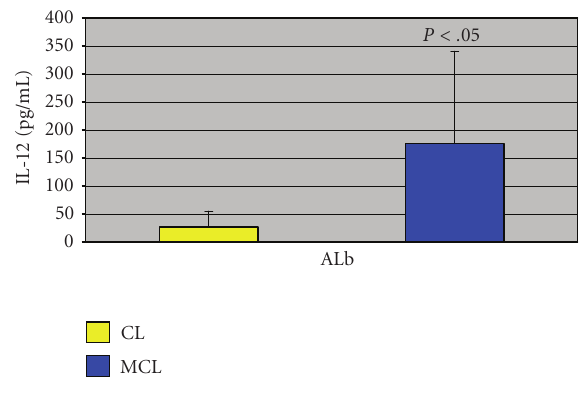
Figure 3: IL-12 production in cell-free supernatants of CL and MCL patients’ PBMCs measured by ELISA upon ALb